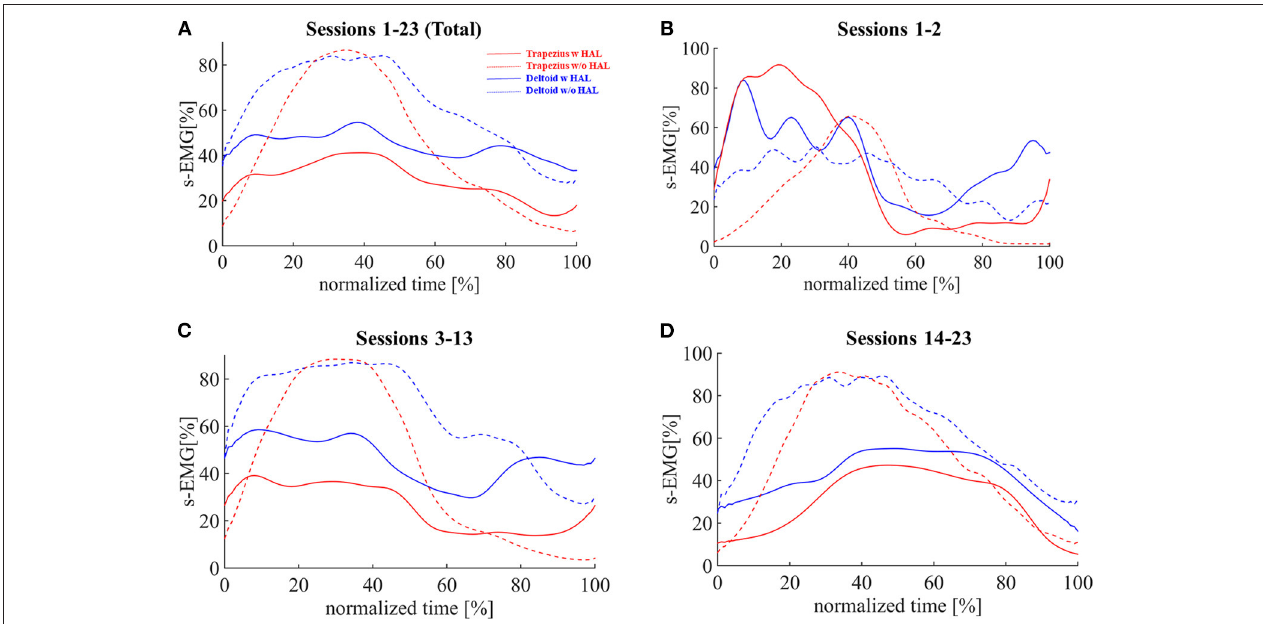
FIGURE 3 | Activities of deltoid and trapezius muscles compared during shoulder abduction training with or without shoulder HAL. Integrated electromyography (iEMG) profiles during the shoulder abduction process. (A) Averaged data from HAL training sessions 1–23 (total). (B) Averaged data from HAL training sessions 1–2. (C) Averaged data from HAL training sessions 3–13. (D) Averaged data from HAL training sessions